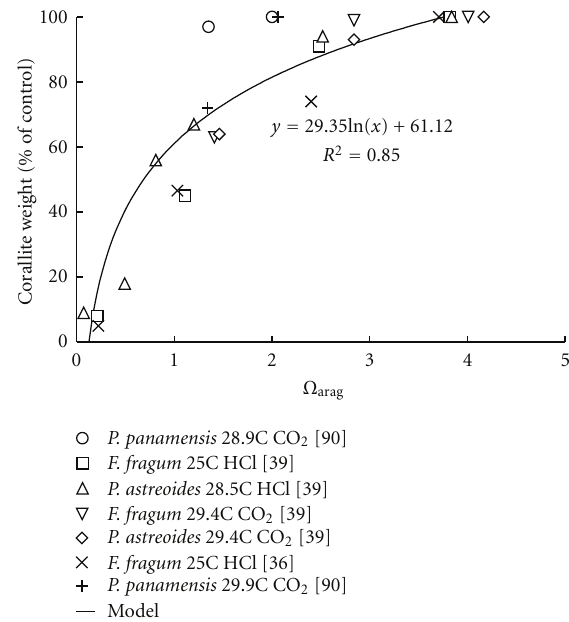
Figure 1: E ff ect of Ω arag on postsettlement calcification rate expressed as a percentage of the control value. Data are from published studies on juvenile